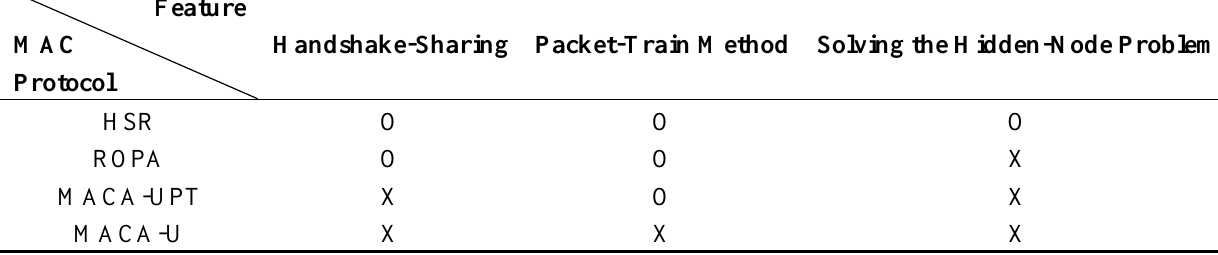
Figure 12. Number of data packet collisions with HSR and ROPA. Table 2. Comparison of the features of MAC